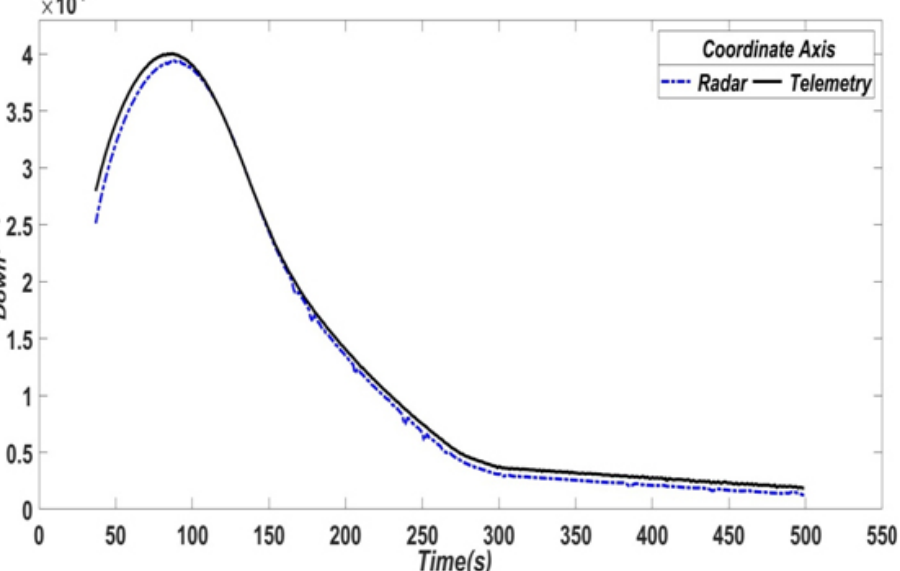
Figure 7. Comparison of radar tracking compared to Telemetry - Slant Range of the survey rocket, on the Cartesian Z-axis with respect to the rocket’s position.